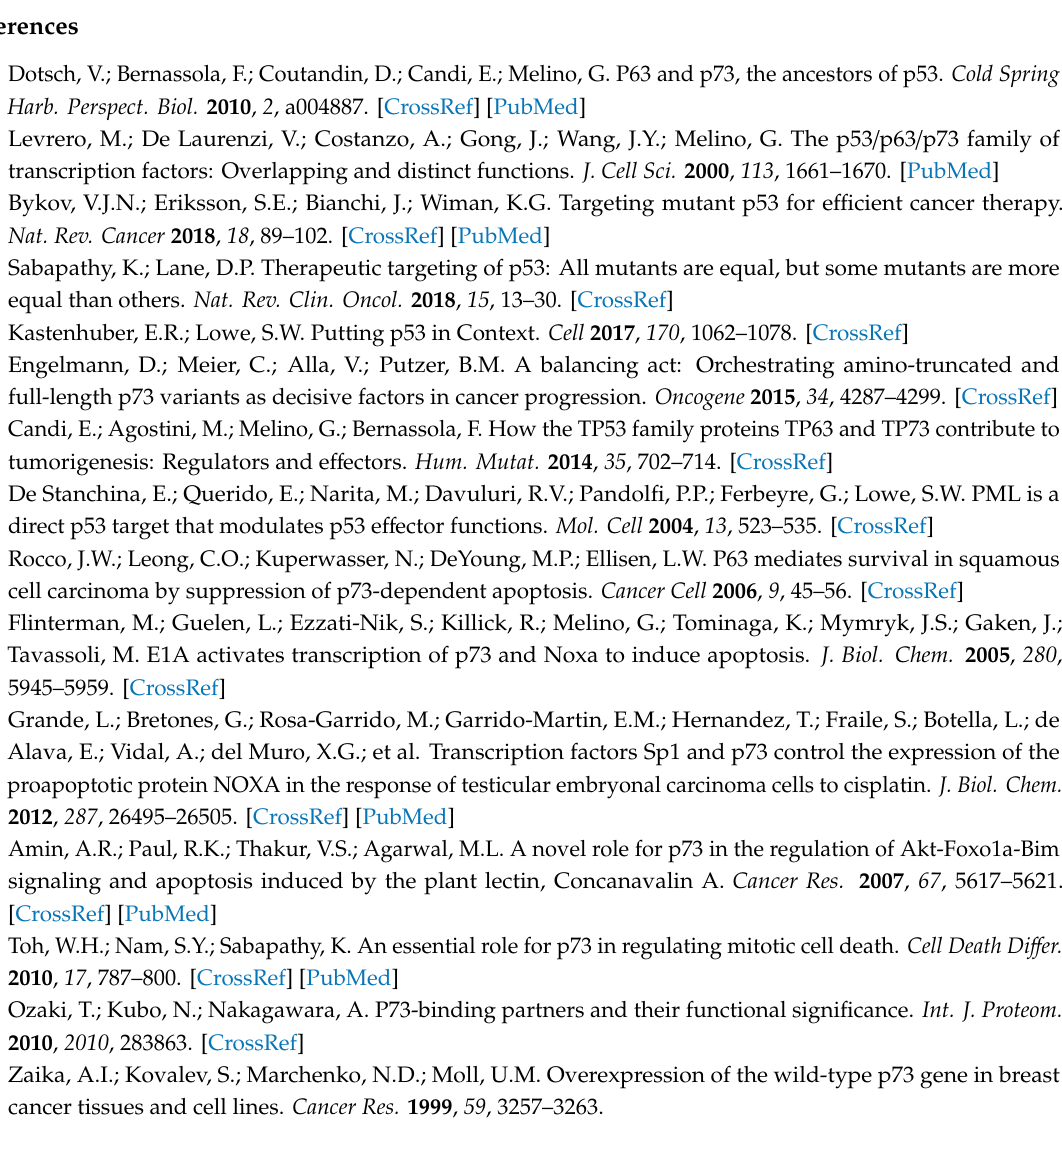
s1. Supplementary Table S1: Detailed analyses of TAp73 target genes identified from 77 focused studies. Supplementary Table S2: Detailed analyses of TAp73 target genes identified from genome-wide